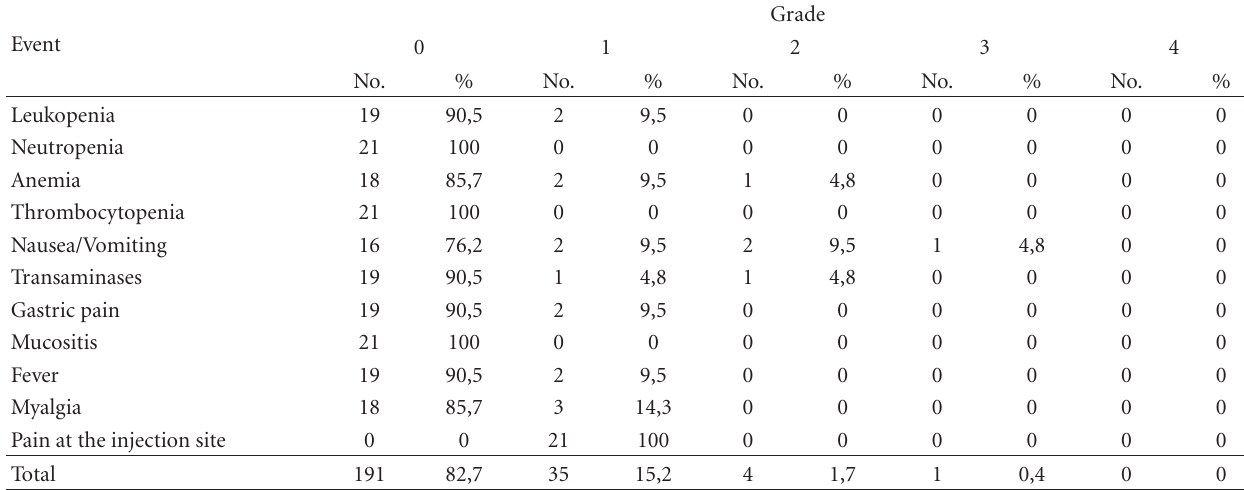
Table 2: Summary of the adverse events.